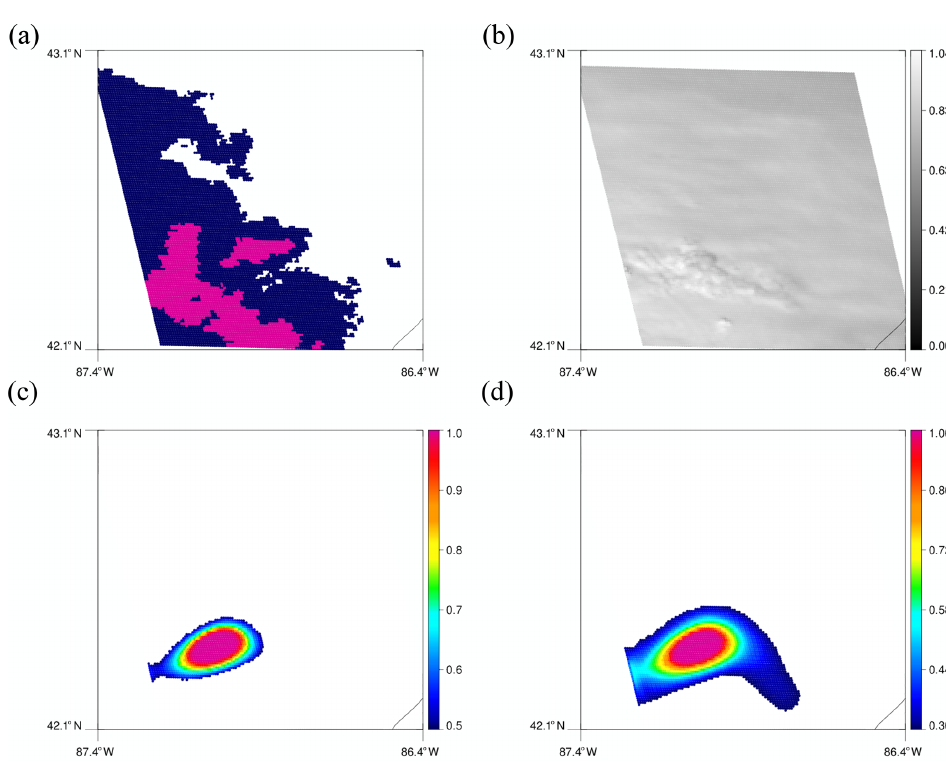
Figure 8. Same as Fig. 6 but for the upper green box in Fig.